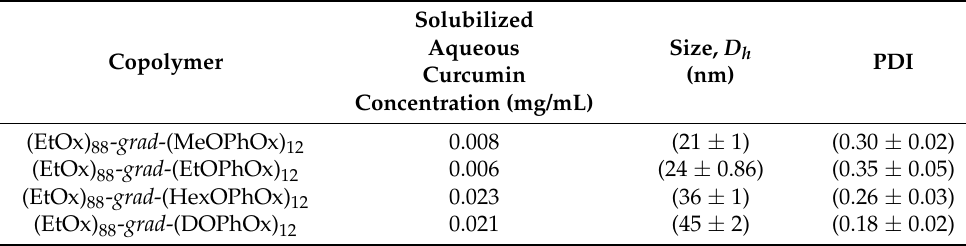
Table 2. Volume-weighted average size of curcumin-loaded (curcumin concentration in feed is 0.036 mg/mL) POx NPs after 24 h from the time of their preparation. The autocorrelation functions of the scattered intensity were analyzed using the cumulants method to determine the D h